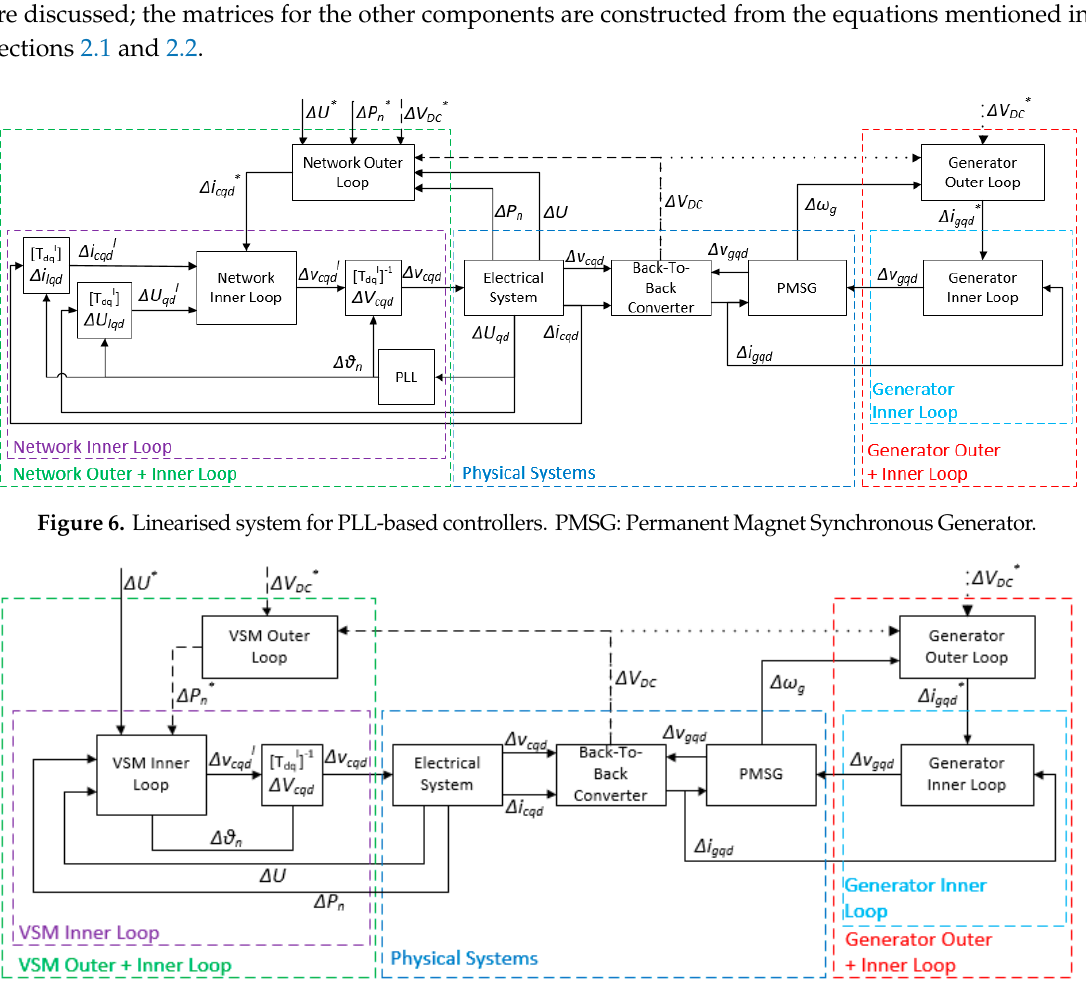
Figure 7. Linearised system for VSM controllers.